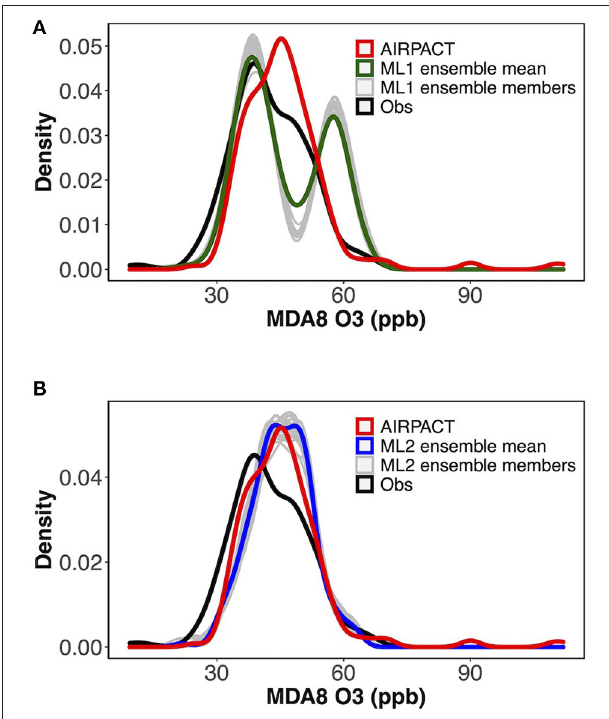
FIGURE 7 | Distributions of observed and (A) ML1, (B) ML2 model predicted MDA8 O 3 in 2019 and 2020.